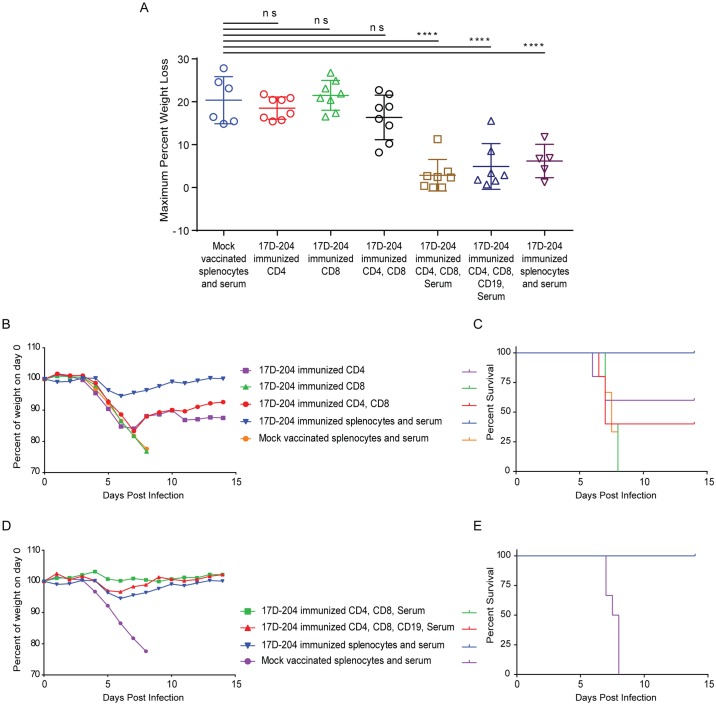
Complete protection against wtYFV requires serum and CD4+ T cells.Cell populations were magnetically enriched according to S2 Fig, mixed as indicated and adoptively transferred into naive eight week old mice. Some groups also received passive transfer of serum. Control groups received passive transfer of serum and total splenocytes from 17D-204 immunized or mock vaccinated animals. Twenty-four hours after the transfer, mice were challenged with Ang71 and monitored daily for (A -B, D) weight and (C and E) survival. Weight is expressed as a percentage of weight on d0 of challenge [ns, not significant; ***, p≤0.0005; One-way ANOVA with Tukey's multiple comparisons test]. Refer to Table 1 for statistics comparing percent of survival and numbers of animals. These data are the combined results of two independent experiments. These results were acquired simultaneously with those depicted in Fig 5, and control groups are shared with those depicted in Fig 5.